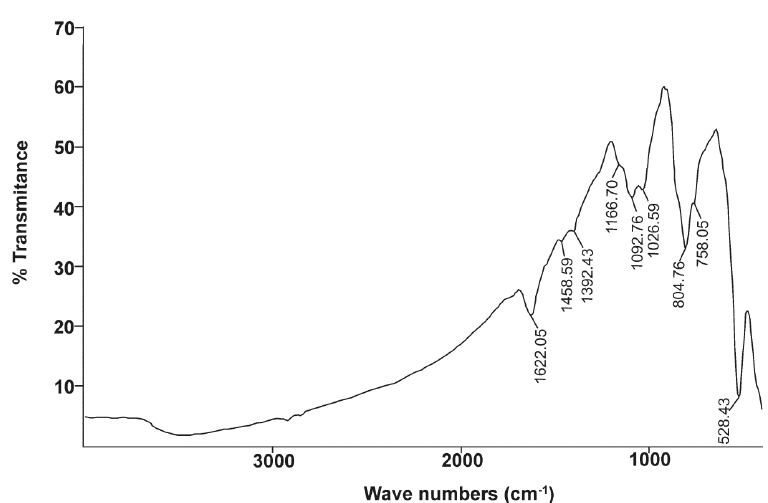
Figure 7. Characteristic Infrared spectrum for bismoclite–preisingerite pockets from San Francisco de los Andes (Sample: 05–BiOCl–02).